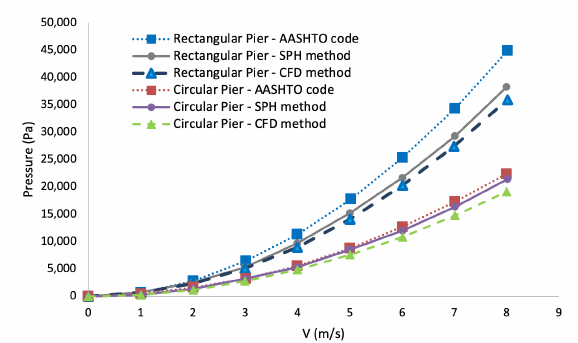
Fig. 8. Equivalent fluid pressure predicted by SPH model, CFD method and AASHTO LRFD for rectangular and circular